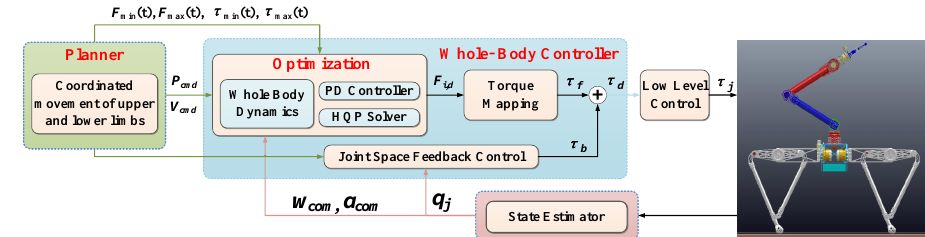
Figure 6. Locomotion framework based on whole-body